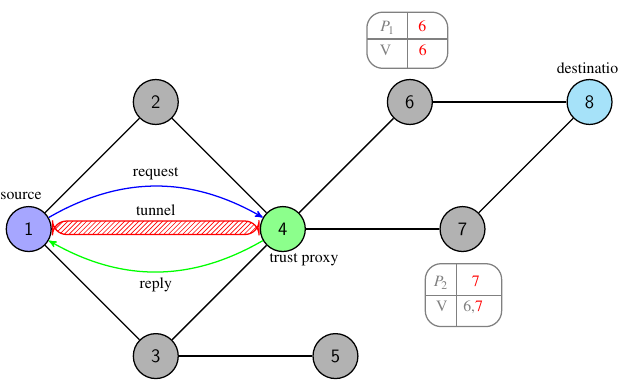
Figure 5. Key negotiation delegated to a trusted proxy (here represented by node